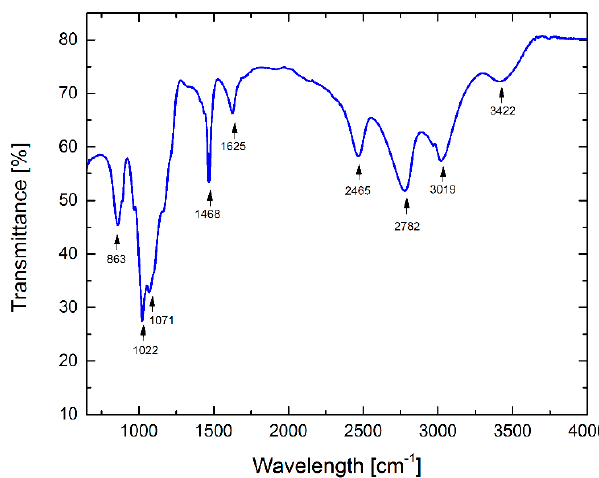
Figure 3. FTIR spectra of as prepared SWCNTs.